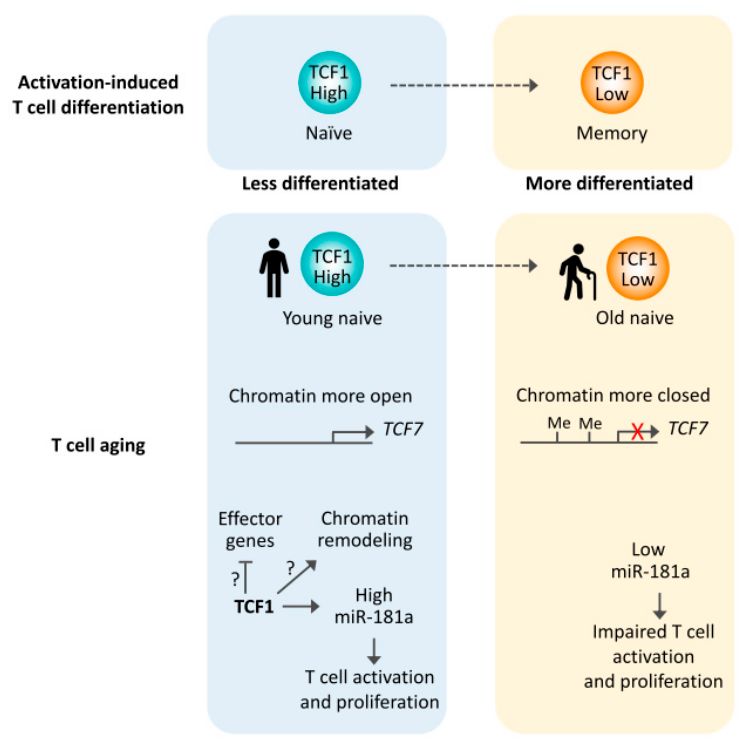
Figure 2. Reduced TCF1 expression in T cell aging. Activation-induced T cell differentiation from naïve to memory T cells is coupled with reduced TCF1 expression. Similar to memory T cells, aged naïve T cells have reduced TCF1 expression, at least in part due to reduced chromatin accessibility and increased DNA methylation at the TCF7 gene. miR-181a is one TCF1 targets in naïve T cells, with miR-181a levels being critical for protective antiviral immune response.